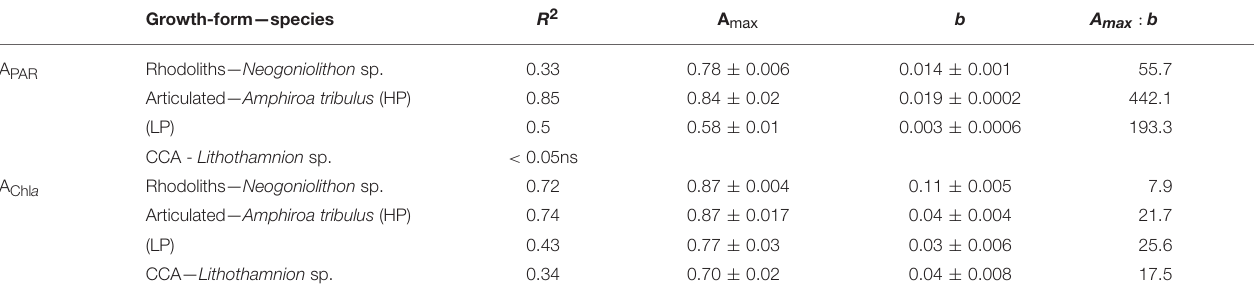
TABLE 1 | Parameters describing non-linear association between absorptance, estimated for the PAR average (A PAR ) and for the chlorophyll a –Chl a - red peak at 680 nm (A Chl a ), and total pigment (mg pigment m − 2 ) and chlorophyll a (mg Chl a m − 2 ) densities, respectively.